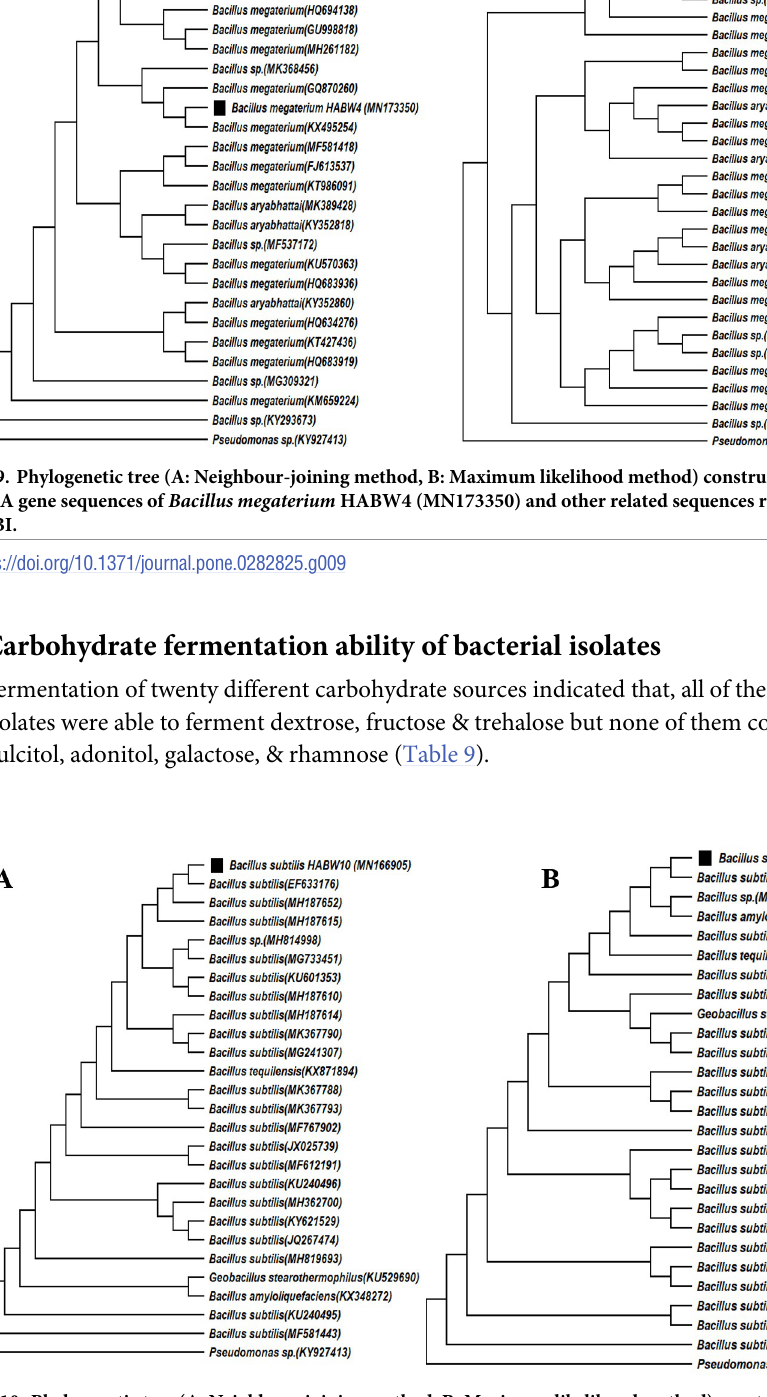
Fig 10. Phylogenetic tree (A: Neighbour-joining method, B: Maximum likelihood method) constructed based on 16S rRNA gene sequences of Bacillus subtilis HABW10 (MN166905) and other related sequences retrieved from